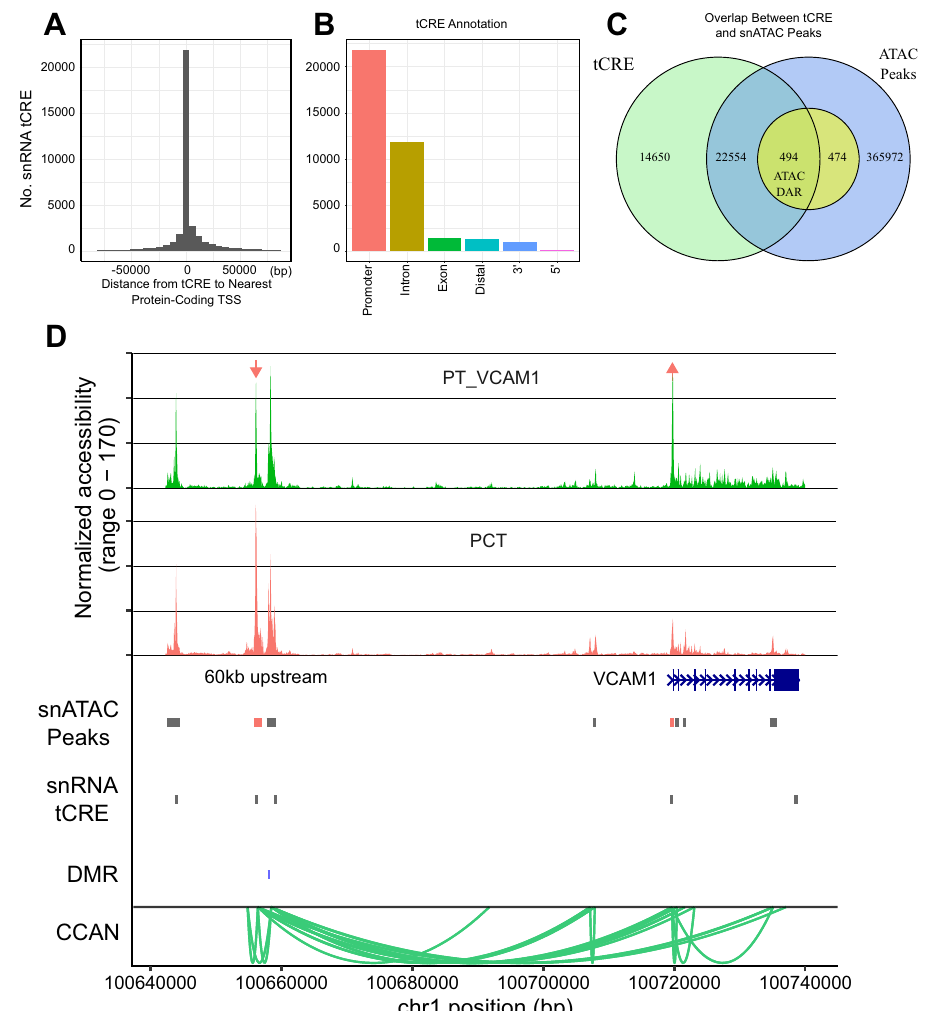
Fig.3|Transcribedcis-regulatoryelements(tCRE)detectedby5-primesnRNA- seq. A Distance from tCRE to TSS. Two control and two DKD samples were sequenced with 5 ’ paired-end sequencing and analyzed with SCAFE. A total of 37,698 tCRE were annotated with ChIPSeeker and displayed relative to the nearest TSS (Source data is provided as a Source Data fi le). B Annotation of tCRE. The relativeproportionoftCREinpromoters,introns,exons,distalintergenic,3-prime, and 5-prime regions is shown (Source data is provided as a Source Data fi le). C Overlap between tCRE and ATAC peaks. tCRE were intersected with cell-speci fi c ATACpeaksandDARinDKDusingGenomicRanges. D Proximalconvolutedtubule and PT_VCAM1 DAR and ATAC peaks in VCAM1 . snATAC-seq coverage plots